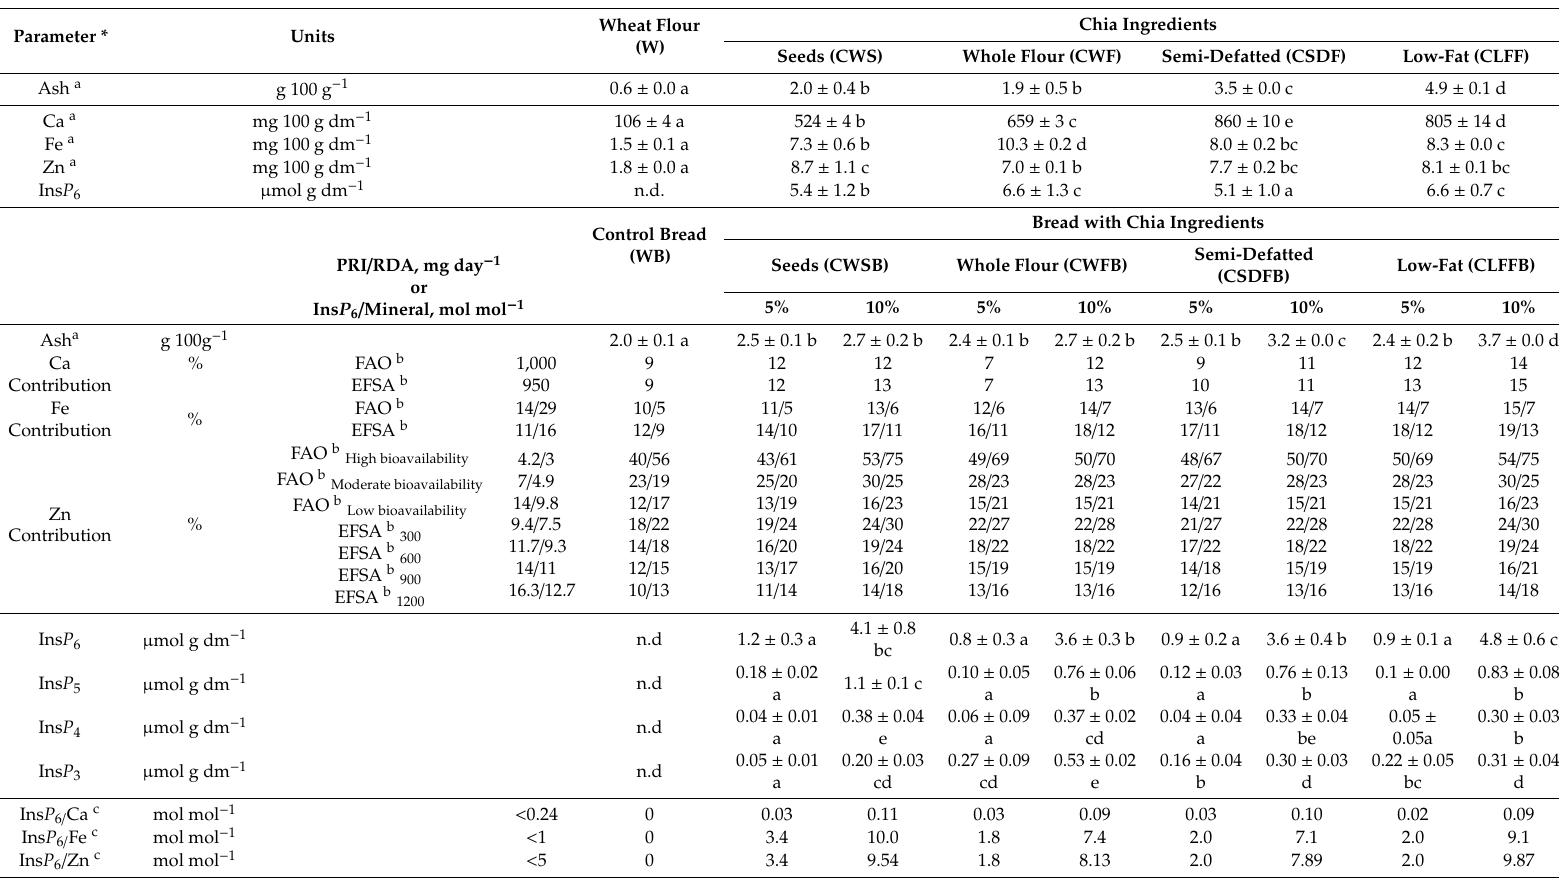
Table 3. E ff ect of bread formulation on mineral dietary reference intake contribution and mineral availability